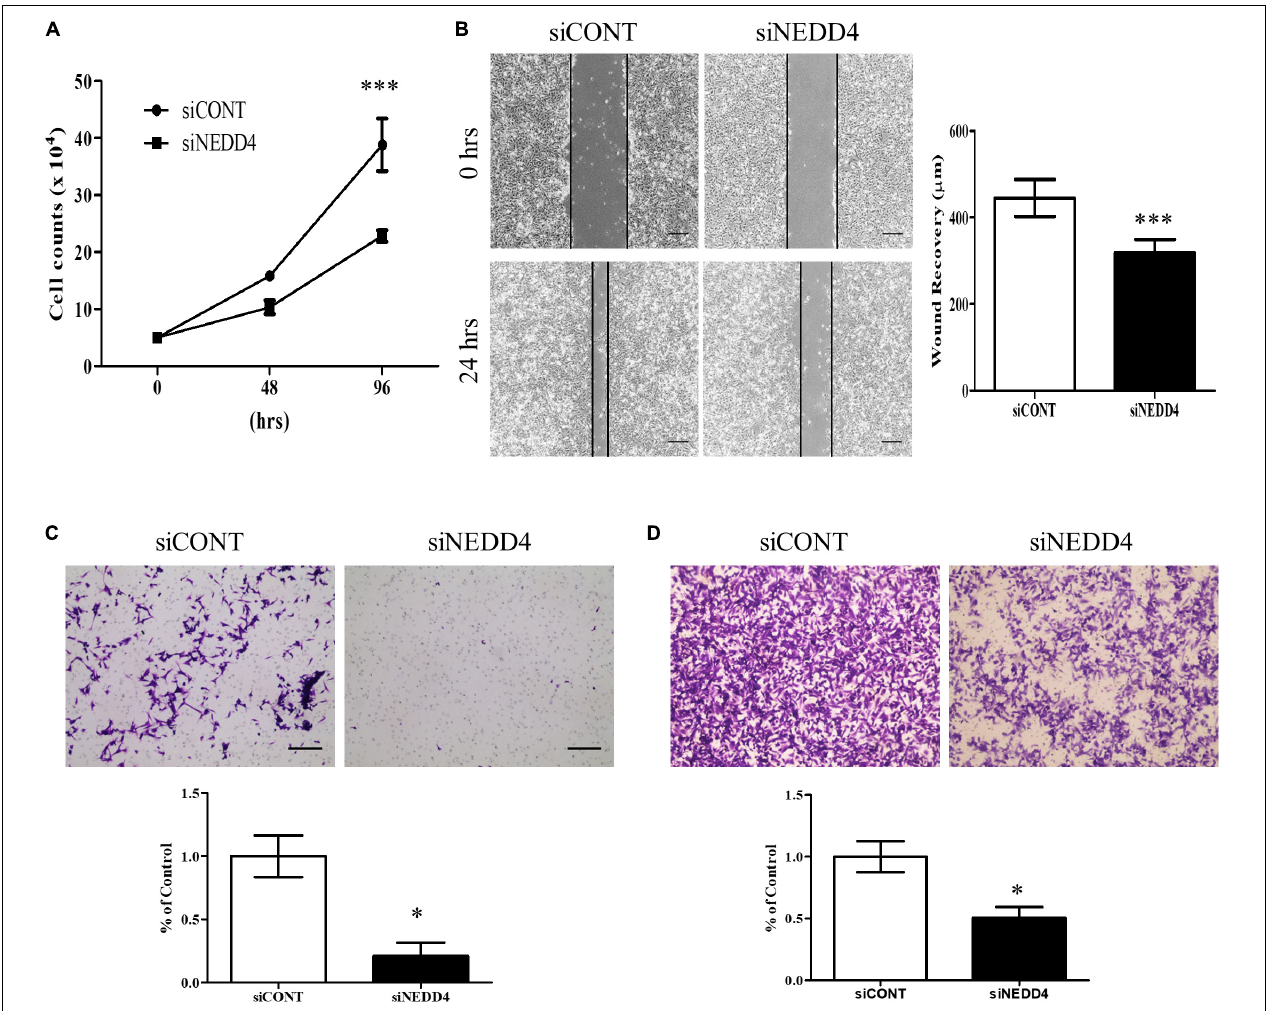
FIGURE 2 | Cell proliferation and migration are decreased in NEDD4-deleted MDA-MB-231. (A) The cell proliferation rate was confirmed by cell counting at 48 and 96 h after transfection of control siRNA (siCONT) and siNEDD4 into MDA-MB-231 ( n = 3). (B) The wound healing assay was performed in siCONT- and siNEDD4-treated MDA-MB-231. At 24 h after wounding, the images were captured to measure the distance that was filled through cell migration and proliferation. The representative images are shown. The average value is shown in the graph ( n = 3). Scale bar, 10 µ m. (C) Cell migration assay was performed with Transwell cell culture chambers in siCONT- and siNEDD4-treated MDA-MB-231. Scale bar, 10 µ m. (D) The invasiveness capacity was confirmed with matrigel-coated transwell chambers in siCONT- and siNEDD4-treated MDA-MB-231. The representative images are shown ( n = 3) (* P < 0.05 and *** P <